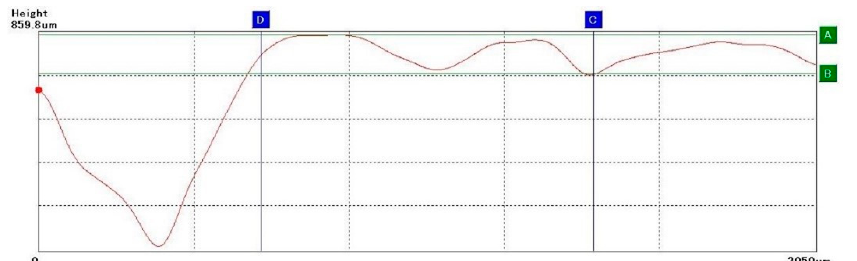
Figure 10. Sampling positioning diagram.